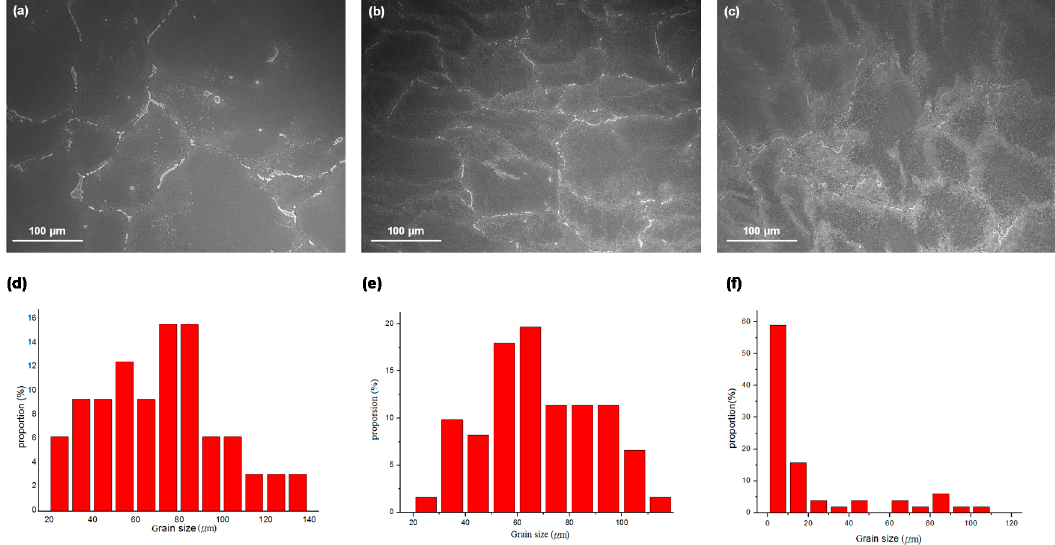
Figure 2. Microstructures of Equal Channel Angular Extrusion (ECAE)-processed Mg-Sn alloys: ( a ) one-pass (1N); ( b ) two-pass (2N); and ( c ) four-pass (4N), and grain size distribution of ECAE-processed Mg-Sn alloys calculated from the microstructure images: ( d ) one-pass (1N); ( e ) two-pass (2N); and ( f ) four-pass (4N).